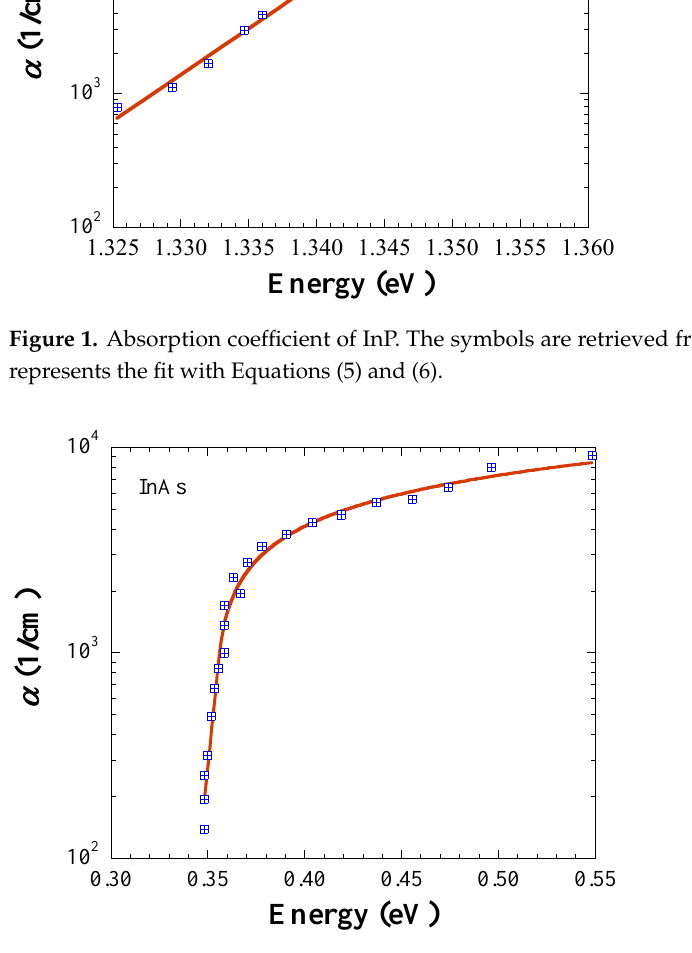
Figure 2. Absorption coefficient of InAs. The symbols are retrieved from Ref. [8], and the solid line represents the fit with Equations (5) and (6).